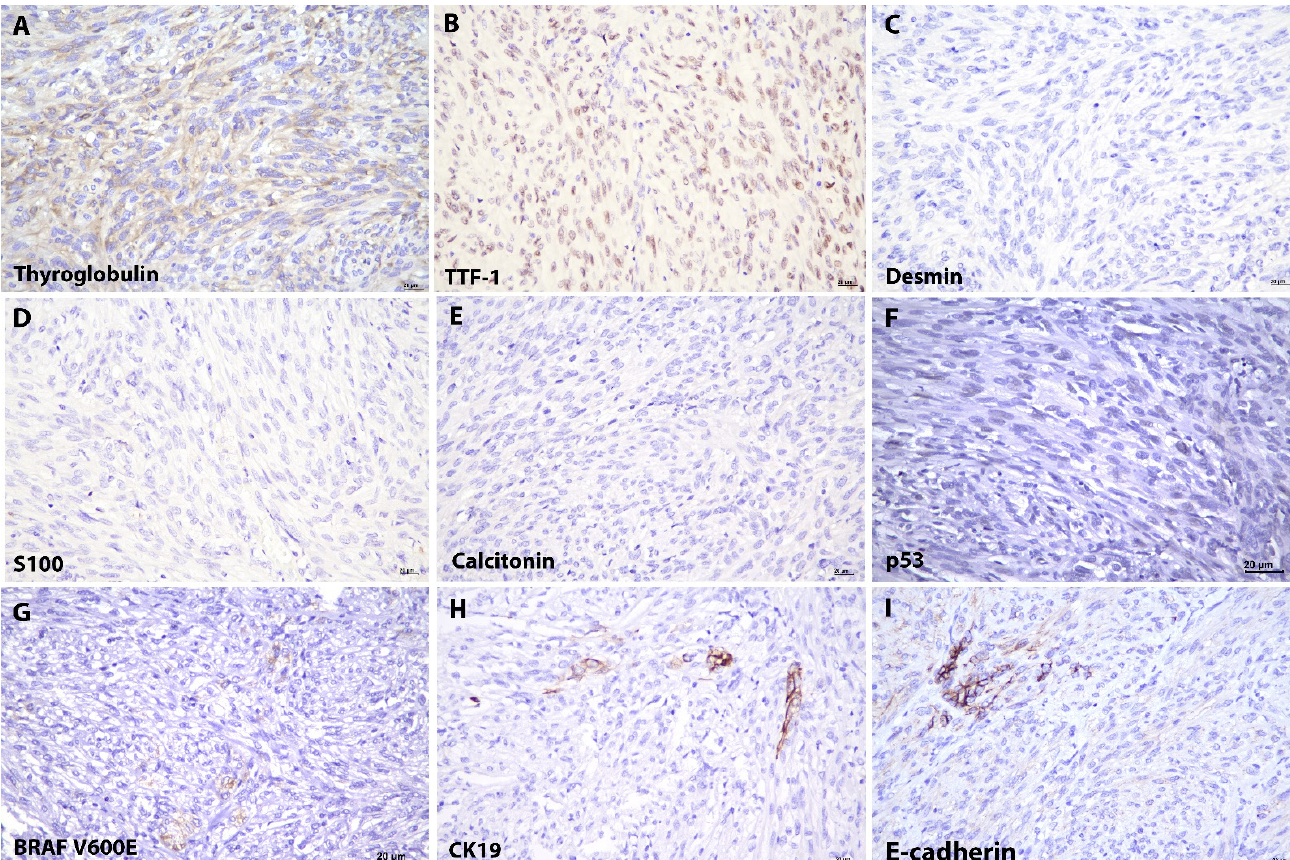
Figure 3. Immunohistochemical Features of Papillary Thyroid Carcinoma with Spindle Cell Metaplasia. The spindle cells exhibit ( A ) thyroglobulin (thyroglobulin, ×400) and ( B ) thyroid transcription factor-1 (TTF-1, ×400) immunopositivity, confirming the thyroid follicular cells in origin. They are immunonegative to ( C ) desmin (desmin, ×400), ( D ) S100 (S100, ×400) and ( E ) calcitonin (calcitonin, ×400). ( F ) p53 (p53, ×400) and ( G ) BRAF V600E mutant protein (BRAF, ×400) were focally expressed by the spindle cells. The spindle cells show a loss of ( H ) CK19 (CK19, ×400) and ( I ) E-cadherin (E-cadherin, ×400) immunoreactivity, compared to the entrapped classical PTC.